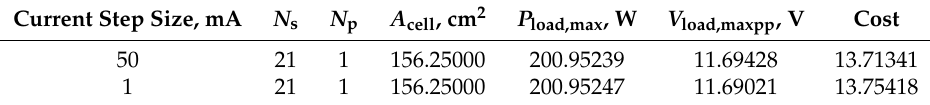
Table 22. Best solution (stack design) of [41].